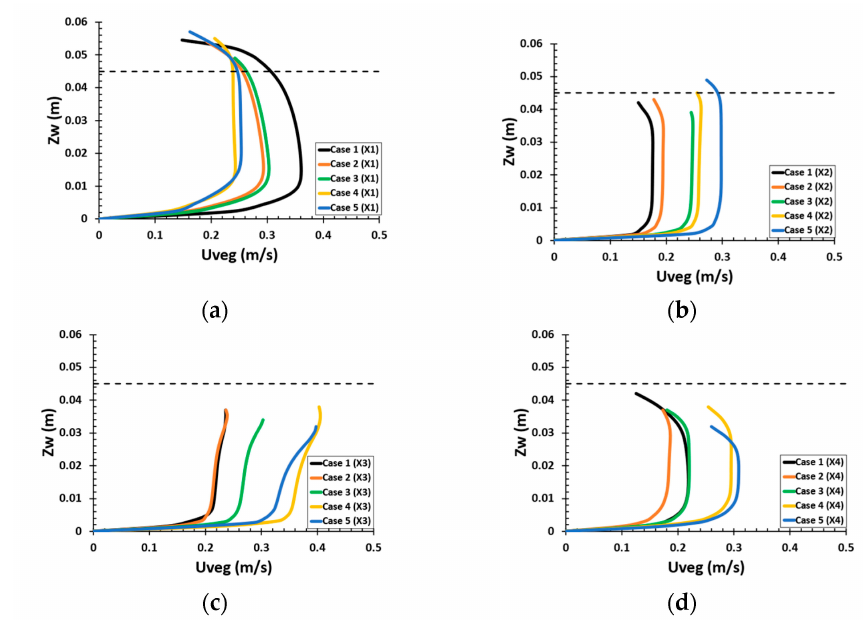
Figure 8. Vertical distribution of streamwise velocities in the vegetation region and downstream region at specified locations ( a ) X1; ( b ) X2; ( c ) X3; ( d ) X4. For the locations, see Figure